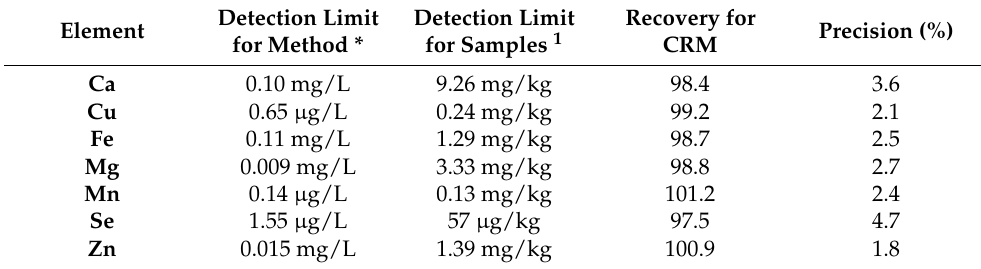
Table 2. The results obtained in the method